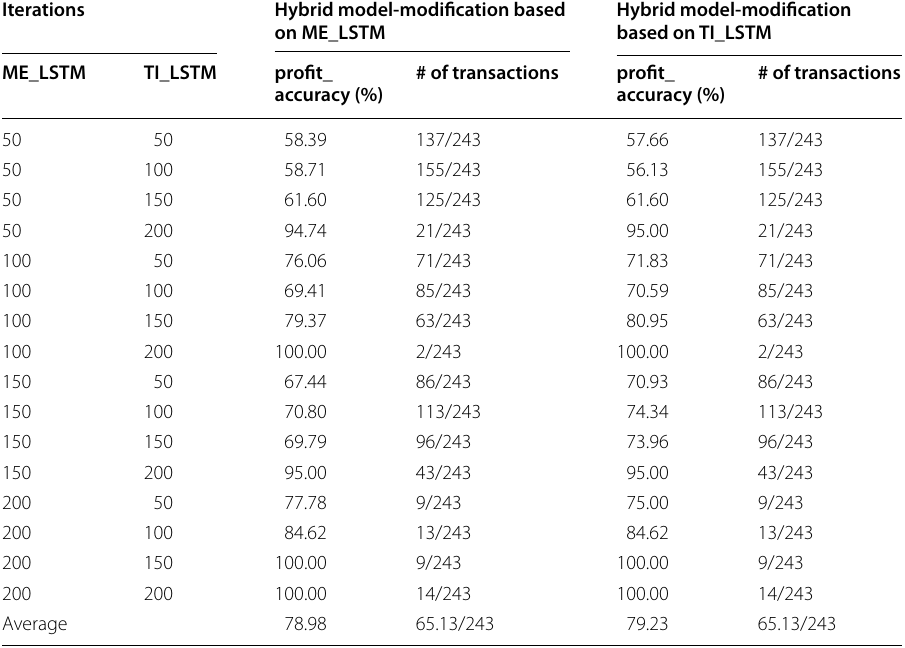
Table 11 Hybrid model: three‑days‑ahead predictions Iterations Hybrid model‑modification based on ME_LSTM